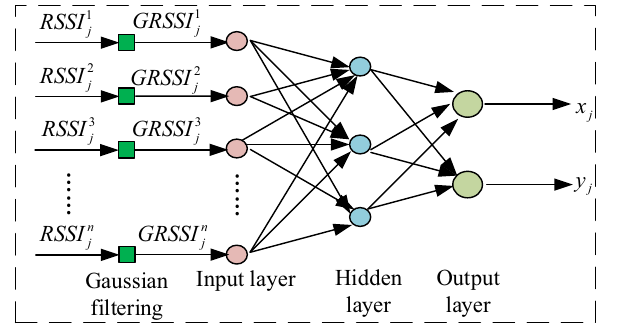
Figure 10. Structure of the positioning